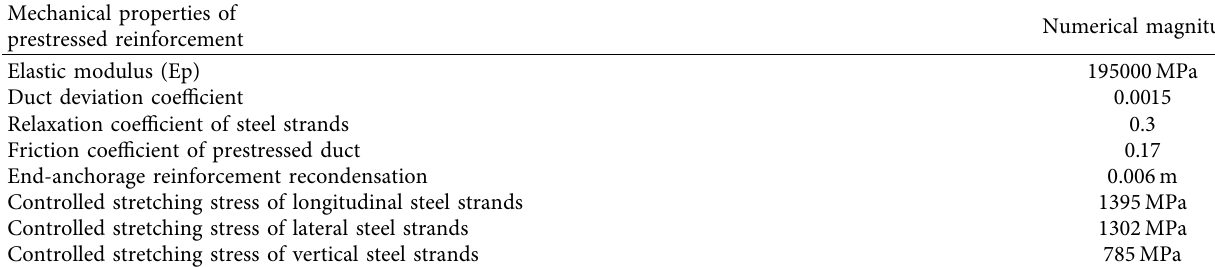
Table 3: Properties of prestressed tendons.